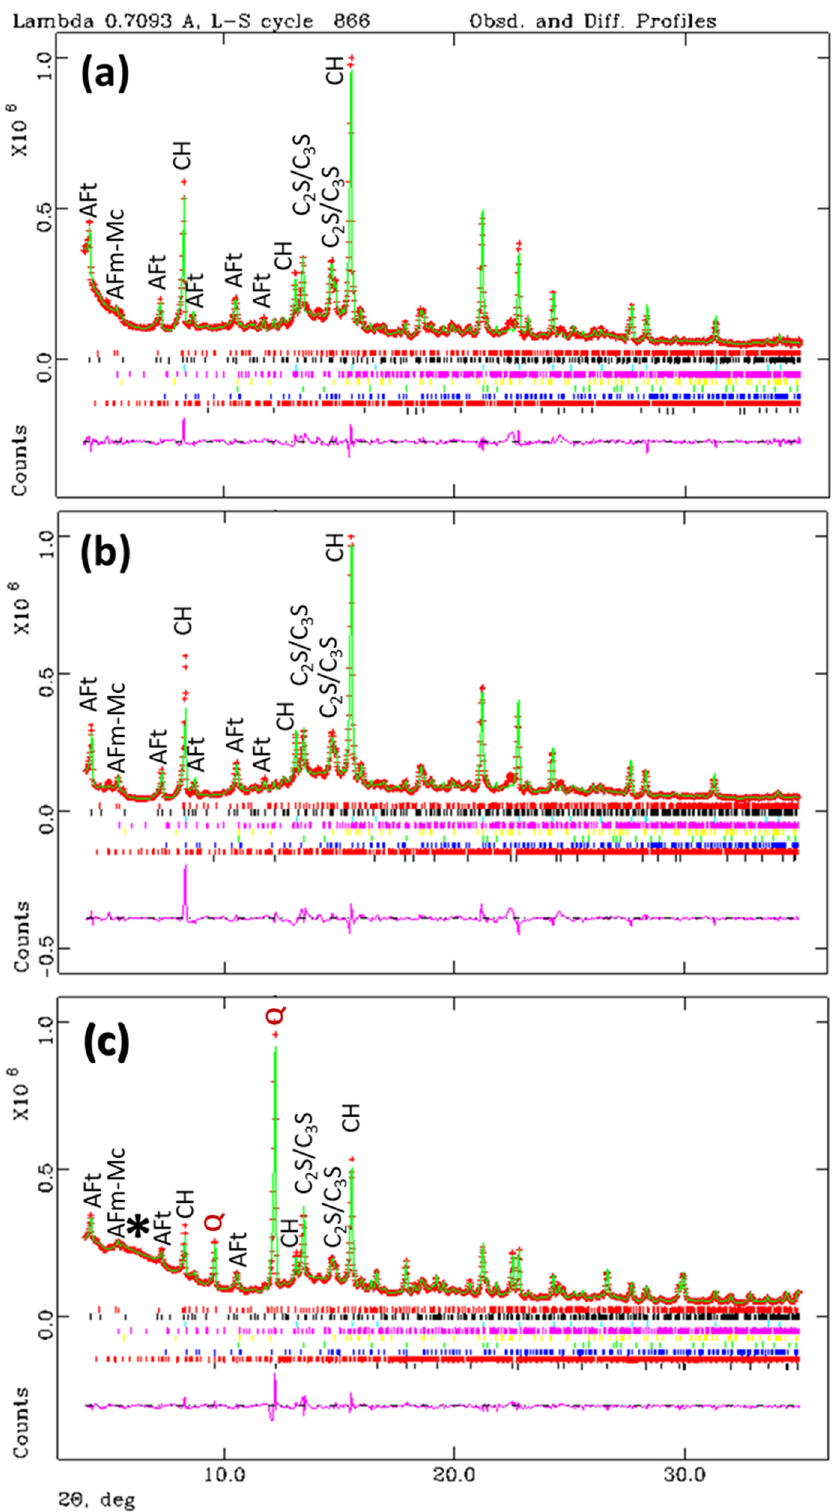
Figure 3. Rietveld plots, λ = 0.71 Å, for the pastes with w/c = 0.65 hydrated at 20 ° C for 50 days ( a ) sample within a capillary of ϕ = 0.5 mm, ( b ) sample within a capillary of ϕ = 1.0 mm, and ( c ) sample with the internal standard and between two Kapton foils. Format and labels as in Figure 2. The hump due to the polymer (Kapton) is highlighted with a